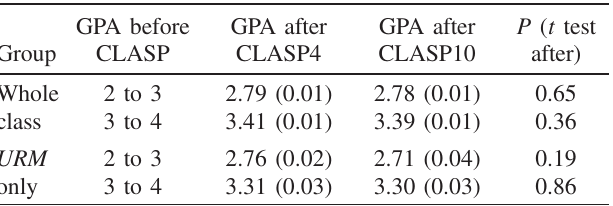
TABLE XI. GPAs of student work after they have completed the CLASP physics series. These are broken down by grade scale in their class as well as by the GPA they had upon entering CLASP. Standard errors are shown in parentheses.